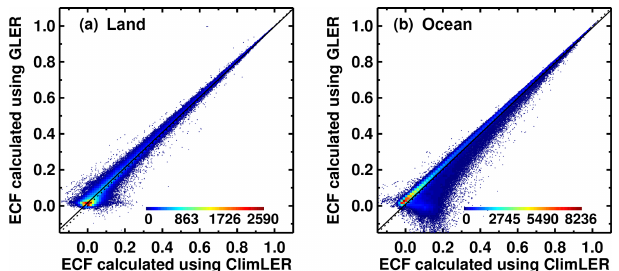
Figure 10. Two-dimensional histograms comparing effective cloud fraction (ECF) retrieved with GLER ( y axes) and climatological LER ( x axes) for land (a) and ocean (b) . The color scale shows numbers of data points. OMI data are for 13 November 2006.